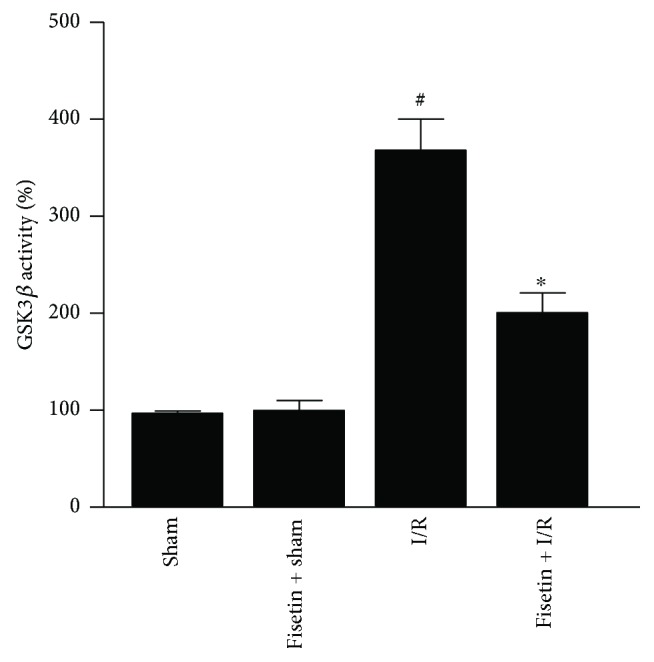
Fisetin inhibits GSK3β activity in myocardial IRI tissues; n = 6/group; #P < 0.001 versus sham/sham ± fisetin; ∗P < 0.01 versus I/R.